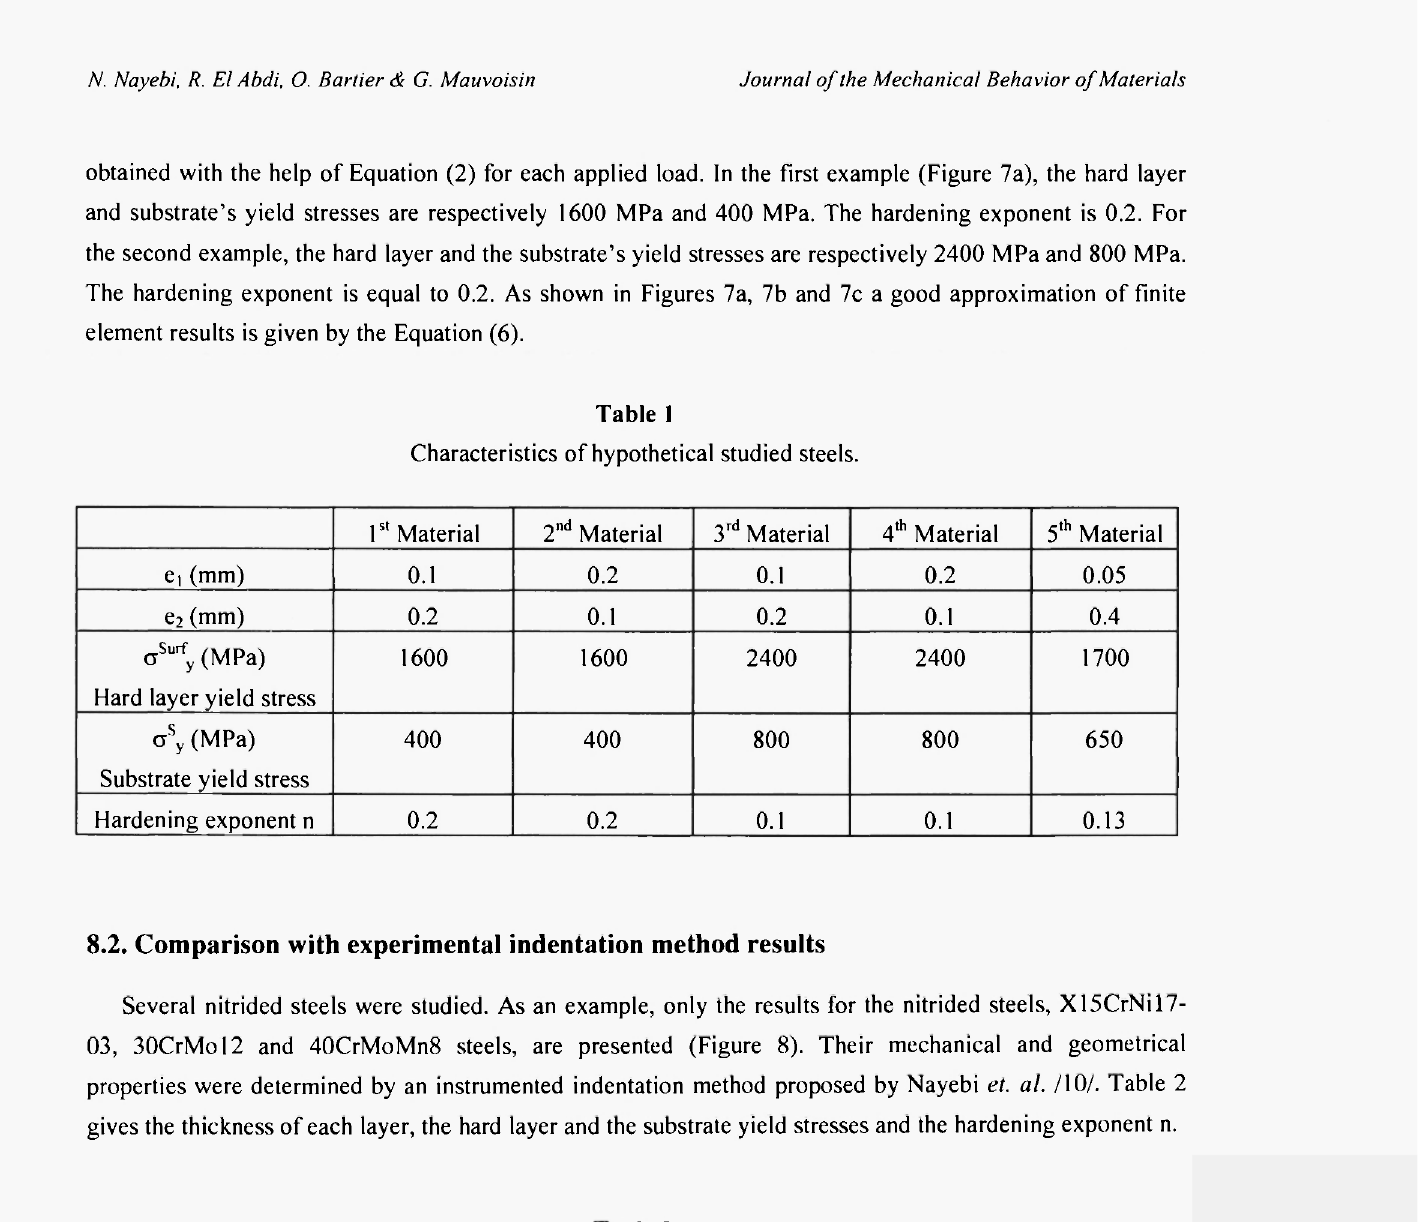
Characteristics of studied nitrided